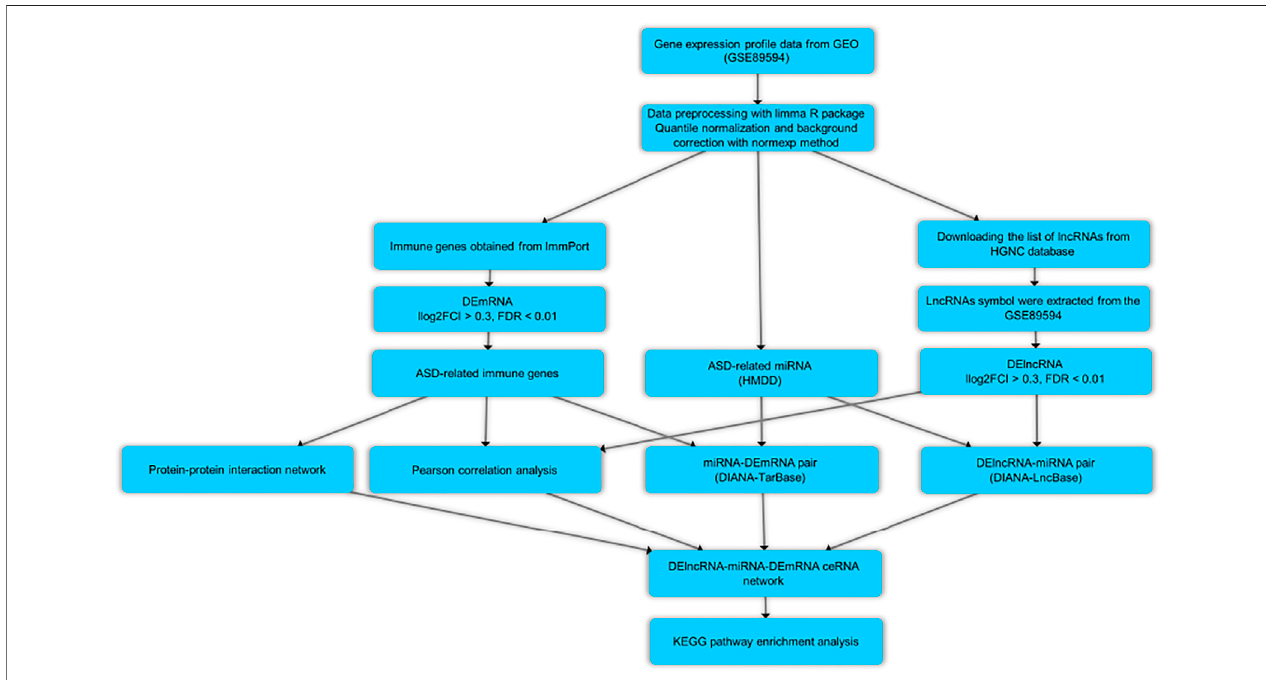
FIGURE 1 | Flow chart of bioinformatics